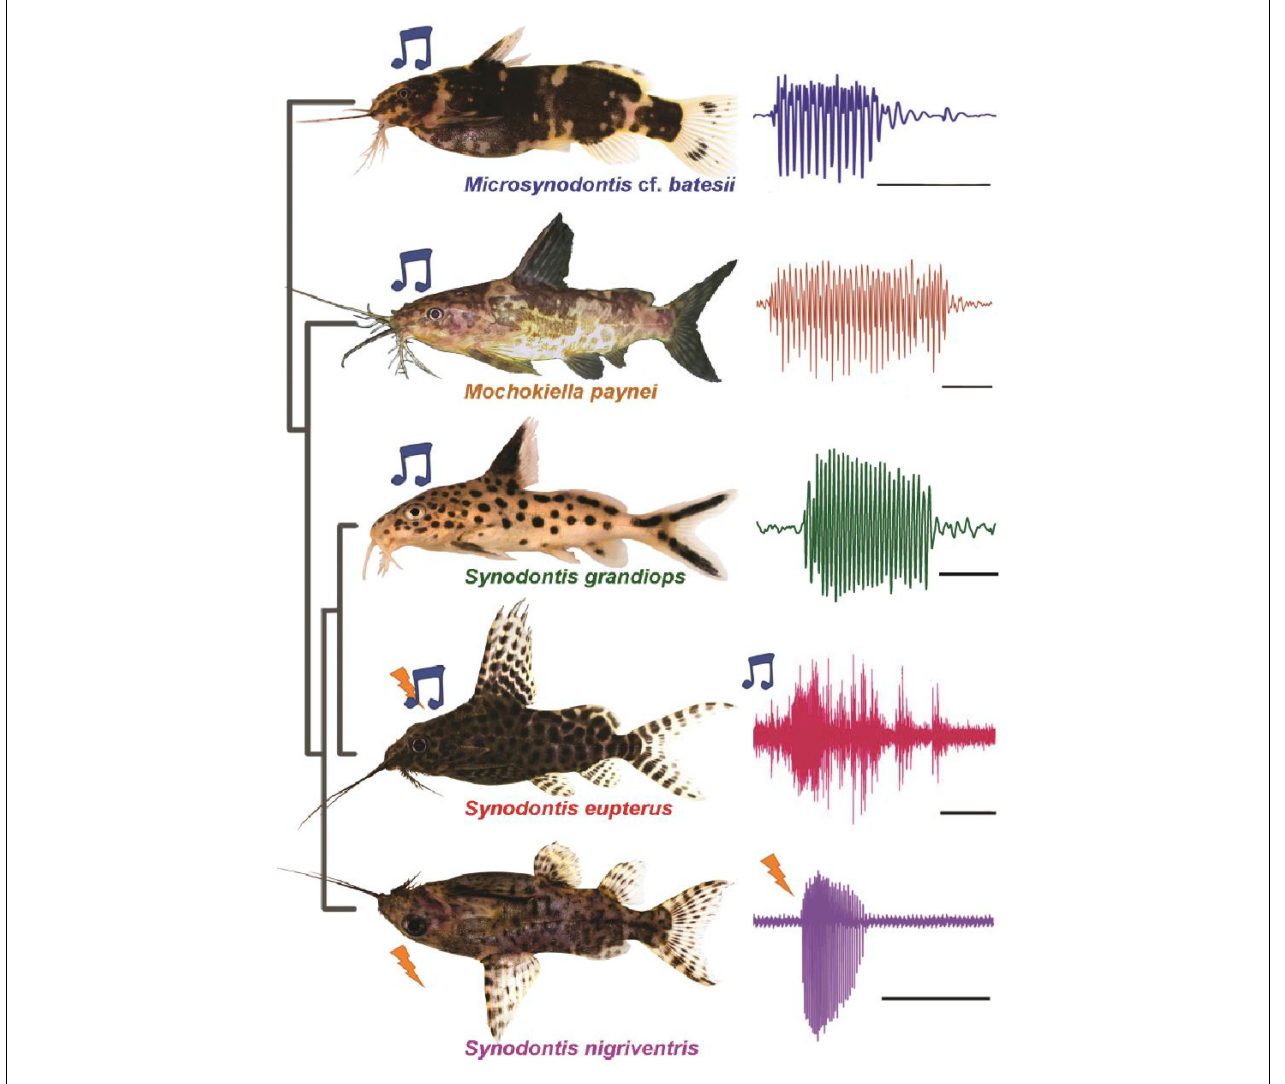
FIGURE 7 | Mochokid catfish produce either vocal and/or weakly electric discharges. (Left) Photographs of five different mochokid species (blue note symbol denotes species that produce sound signal; lightning symbol denotes species that produce electric signal). Species studied so far are either sonic (e.g., top three), generate both types of signals (e.g., S. eupterus ; only sonic signal shown here) or generate only electric discharges (e.g., S. nigriventris ). (Right) Examples of waveforms of signals produced by the elastic spring apparatus. Scale bar is 50 ms for top four species shown and 500 ms for S. nigriventris . Modified and adapted from Kéver et al. (2020) and Kéver et al.